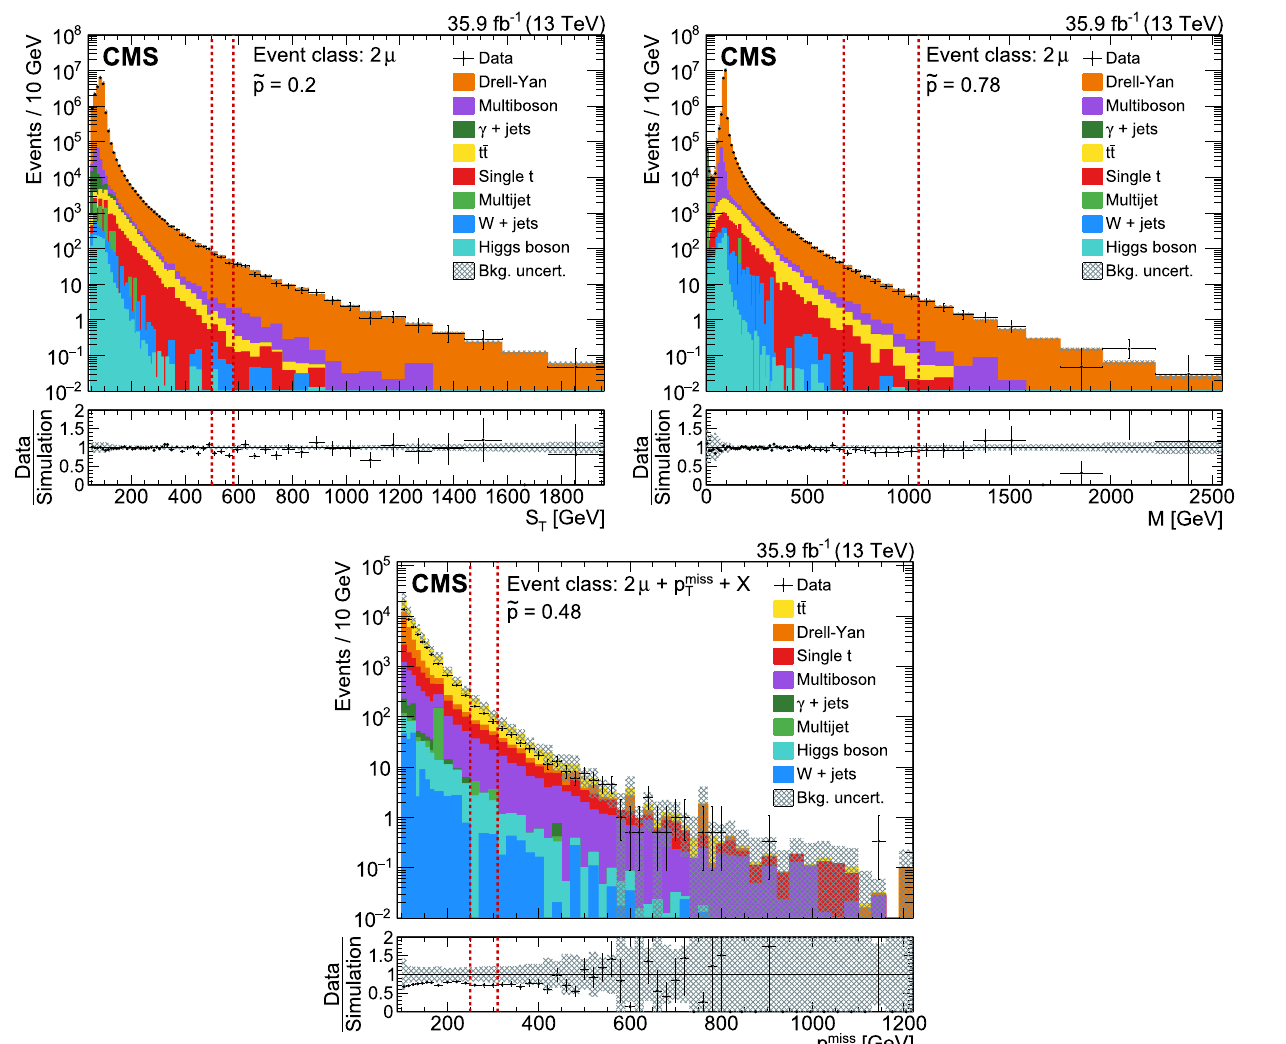
Fig. 10 Example S T (upper left) and M (upper right) distributions as black markers, contributions from SM processes are represented by for the 2 μ exclusive event class, and the p miss distribution for the coloured histograms, and the region enclosed by red dashed lines in T + X inclusive event class (lower). Measured data are shown each figure corresponds to the region of interest determined by the RoI 2 μ + p miss T algorithm described in Sect.